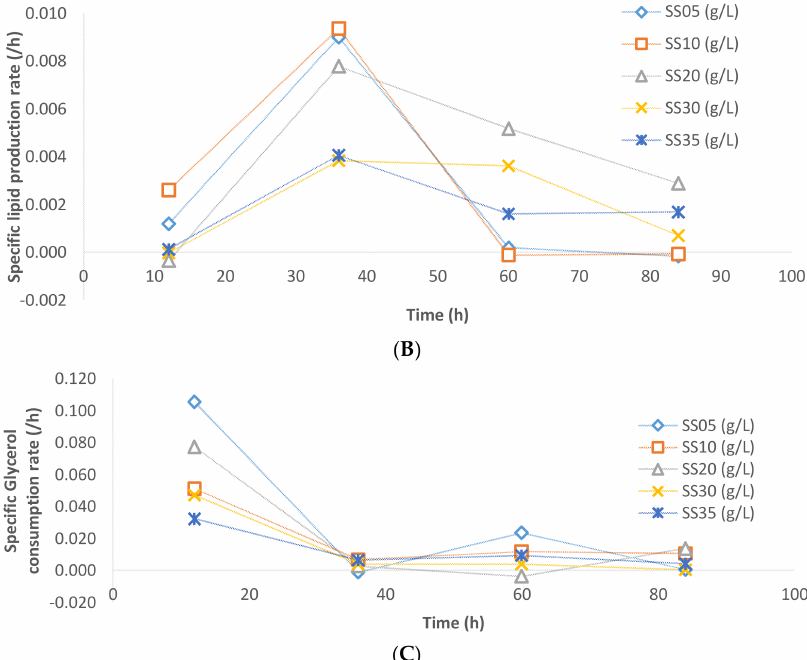
Figure 7. ( A ) Specific growth rate, ( B ) specific lipid production rate, and ( C ) specific glycerol consumption rate comparison between fermentations performed with different concentrations of sludge